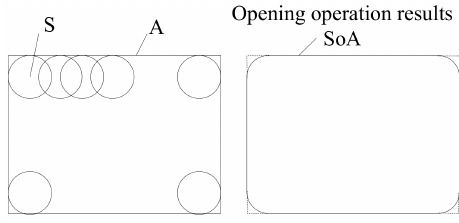
Figure 3. Opening operation schematic